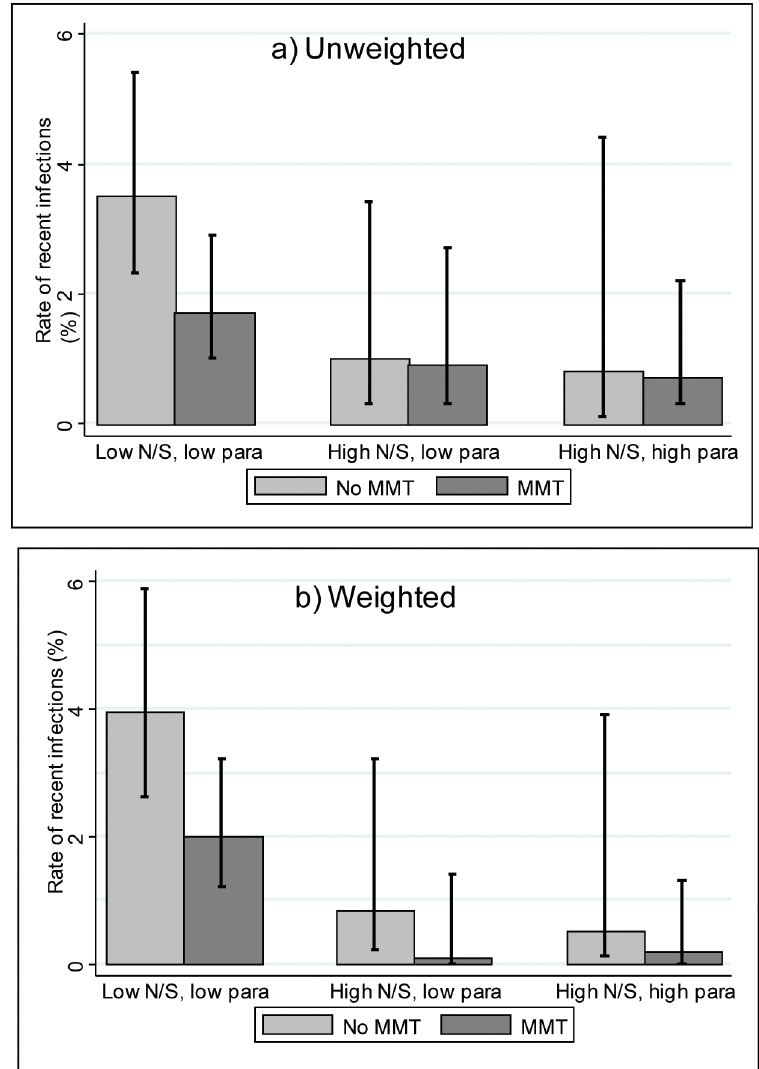
Table 6. Estimated number of new infections and new chronic infections per calendar year based on derived incidence rates a .